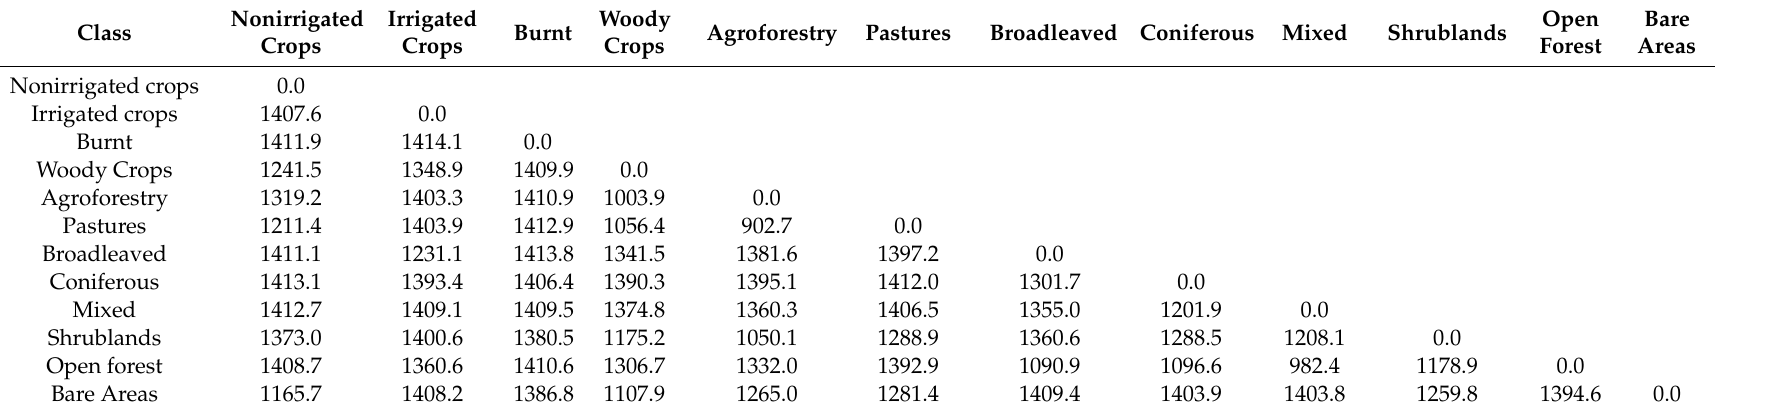
Table A3. The spectral separability analysis using the Je ff ries Matusita (JM) distance for the 1985